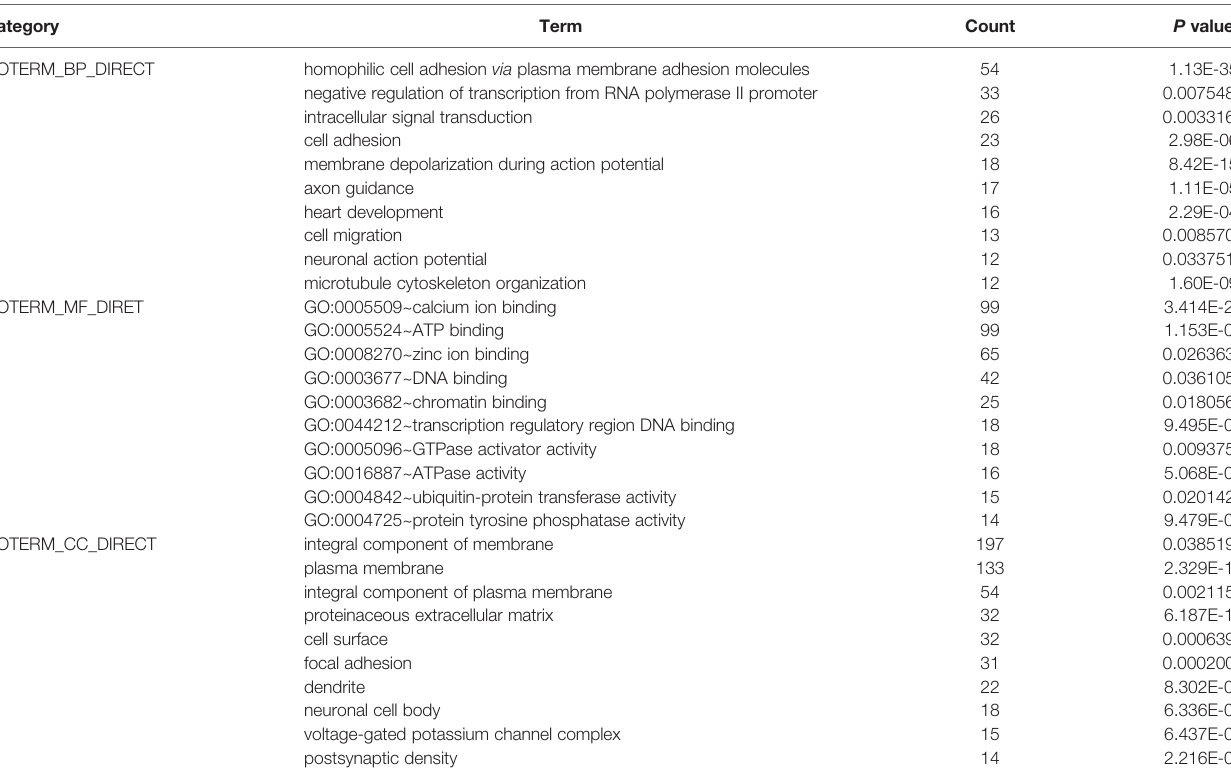
TABLE 2 | Gene ontology analysis of 945 mutant genes in gastric